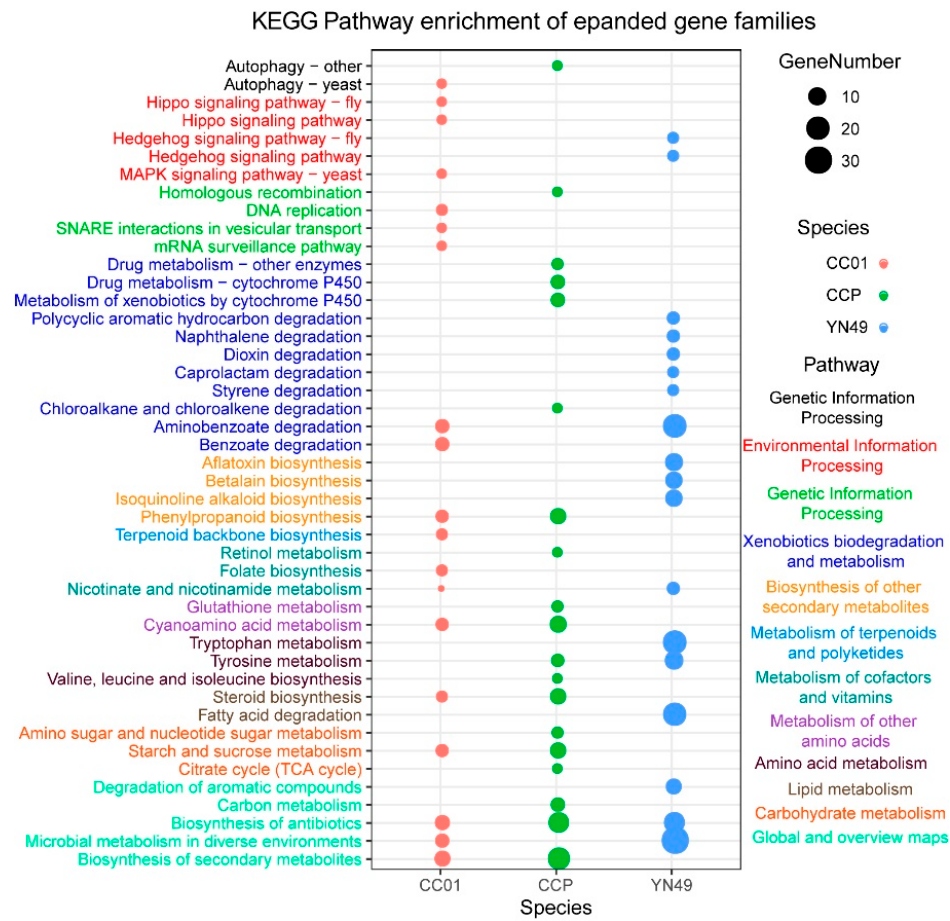
Figure 3. KEGG distribution of expanded gene families in C. cassiicola YN49, CC01 and CCP strains.